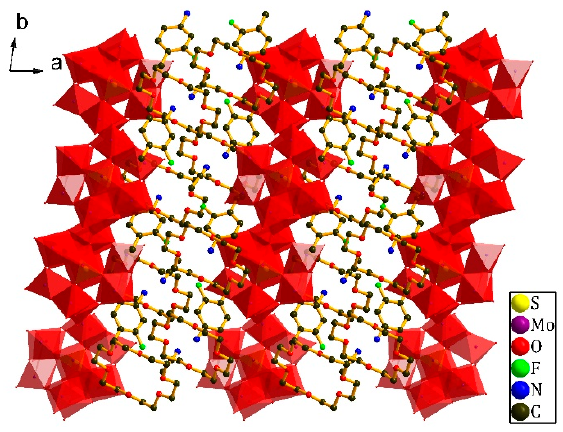
Figure 3. The packing diagram of Crystal 1, viewed along the c -axis.